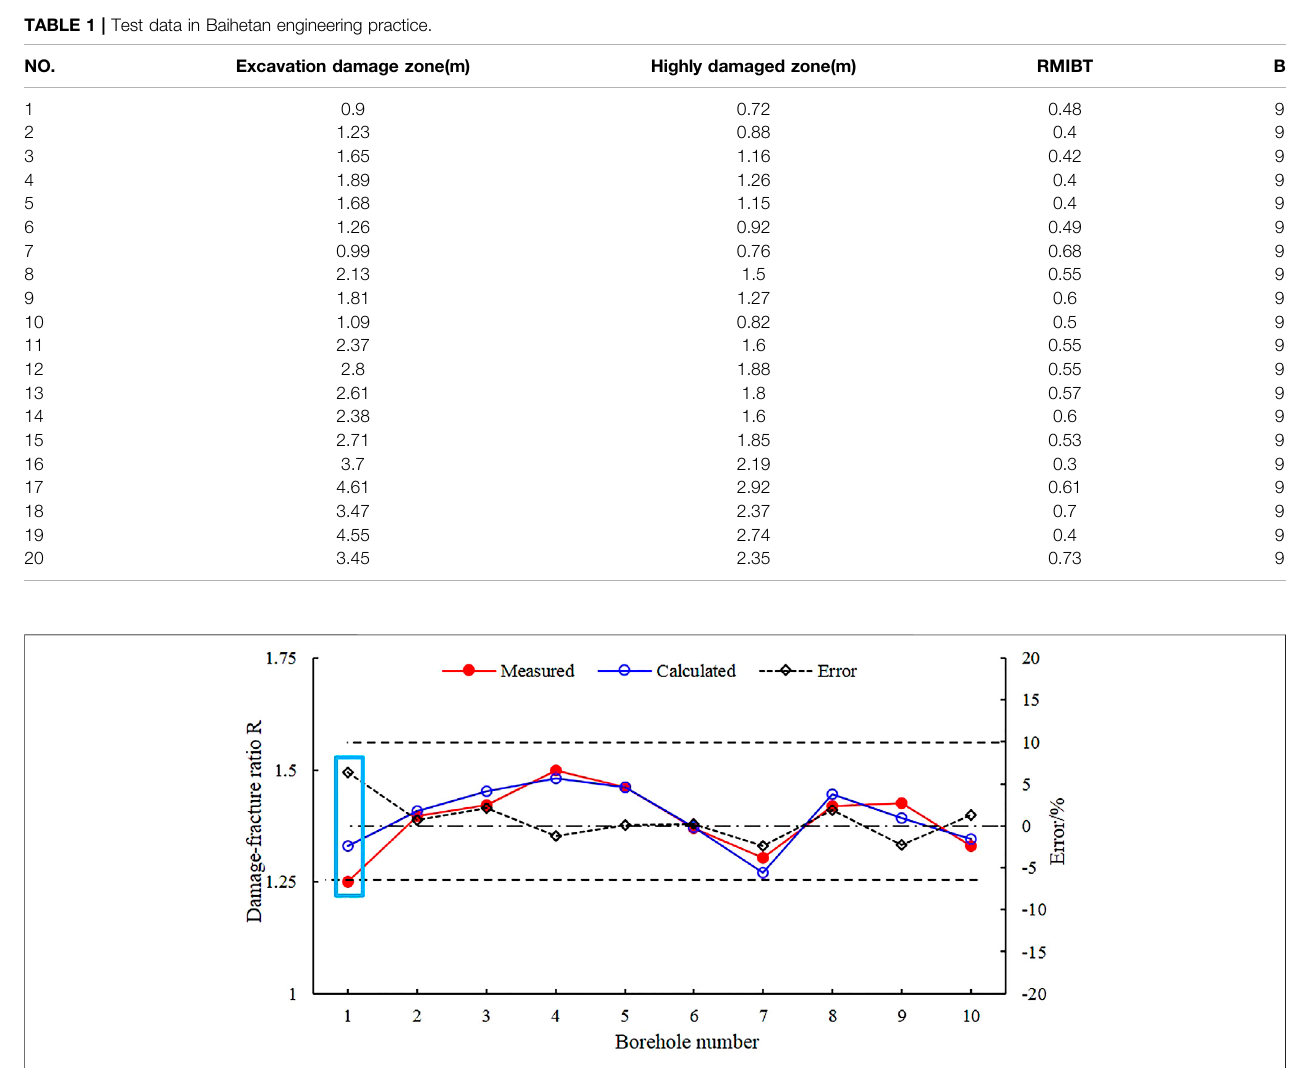
FIGURE 5 | Error analysis of the proposed